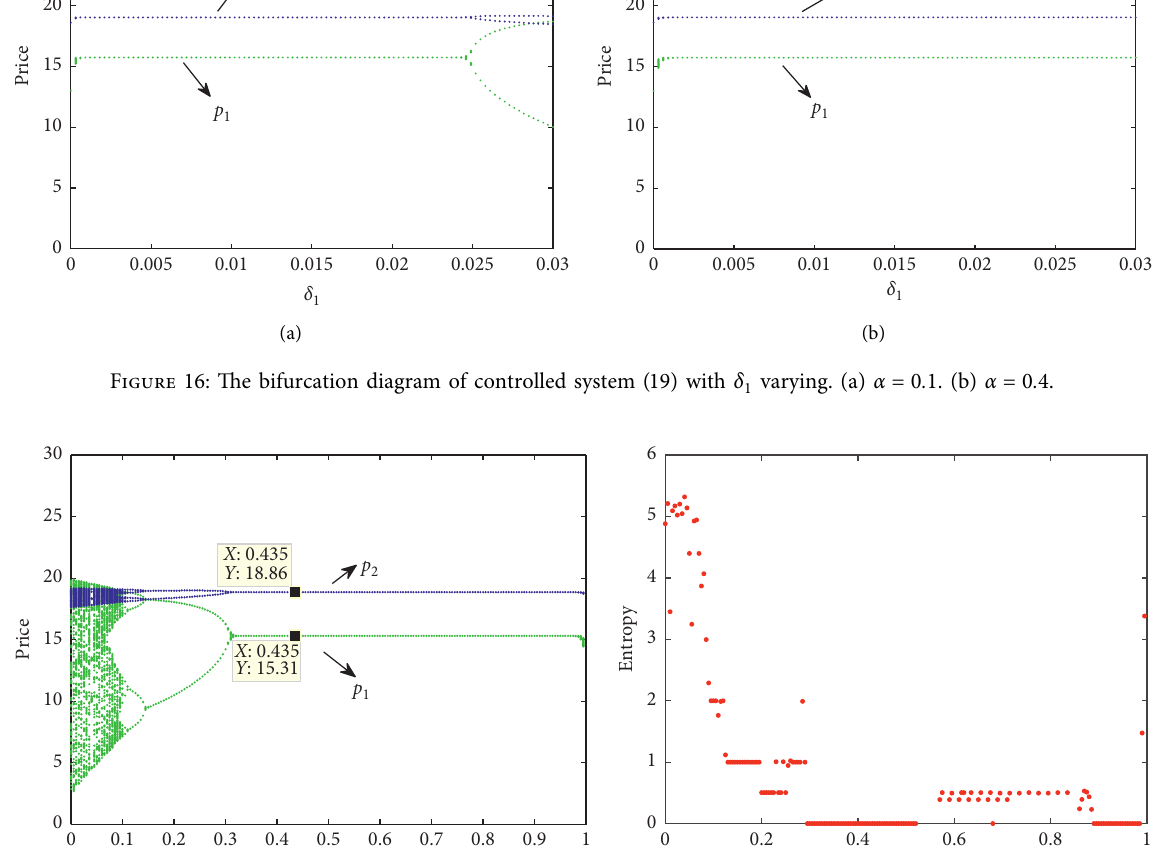
Figure 17: The price bifurcation diagram and entropy of controlled system (19) with α varying. (a) The price bifurcation diagram. (b)